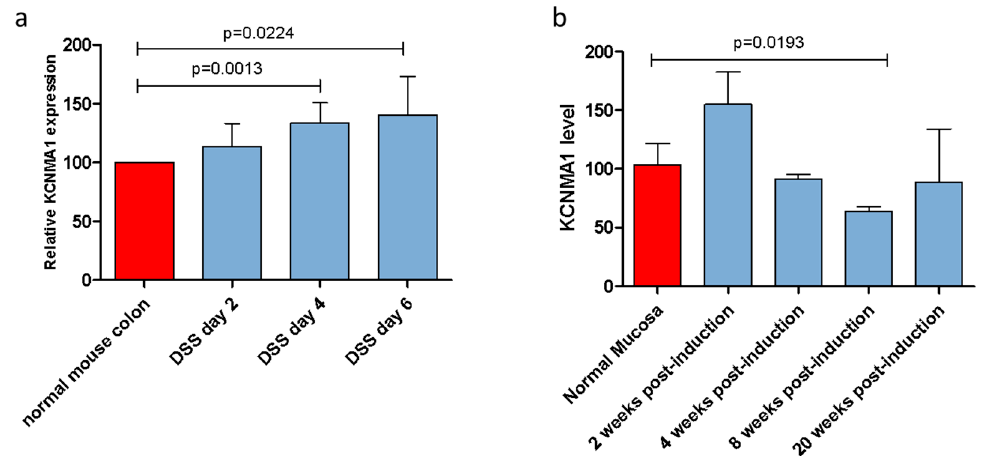
Figure 1. KCNMA1 is modulated in murine models of ulcerative colitis (UC) and colorectal cancer. ( a ) Transcriptional levels of KCNMA1 in a murine model of UC induced by the administration of 3% dextran sodium sulfate (DSS) in drinking water were determined by Real-Time PCR; ( b ) expression of KCNMA1 in the DSS/azoxymethane model was determined by Real-Time PCR at different time points (0, 2, 4, 8, and 20 weeks from disease induction) ( n = 5–6 animals per group). The expression level is presented as percentage of increase as compared to control (normal mucosa) group, which was arbitrarily set to 100. ANOVA followed by Bonferroni post hoc test was used to assess statistical differences among groups.